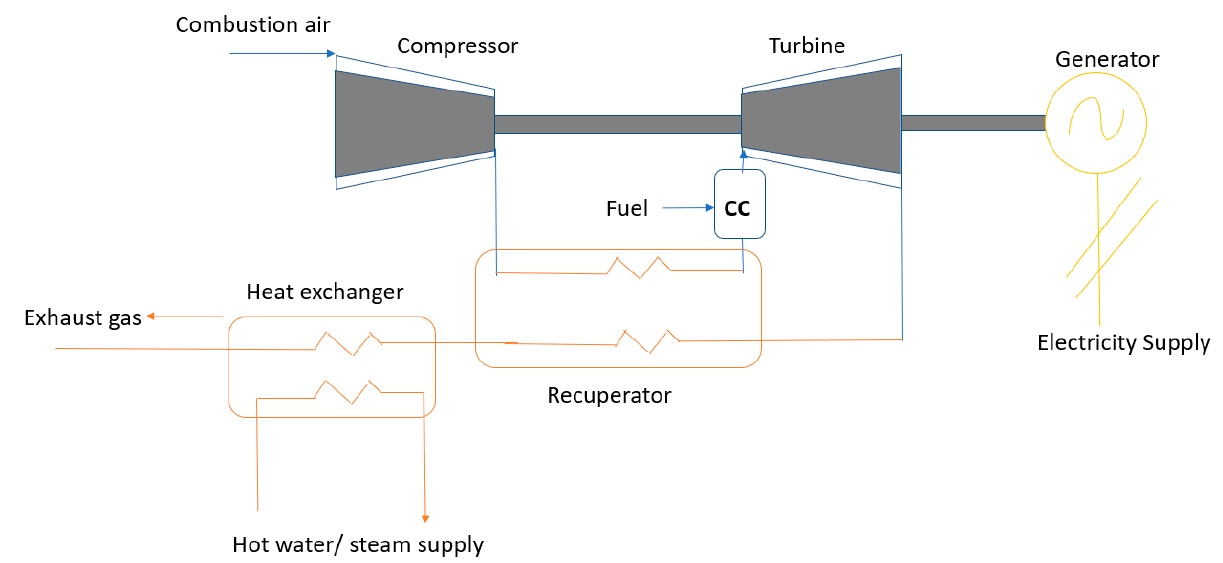
Figure 5. Schematic of a micro gas turbine generator.